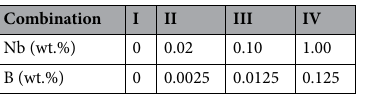
Table 1. Nb-B level range added to the Al–Si–Fe